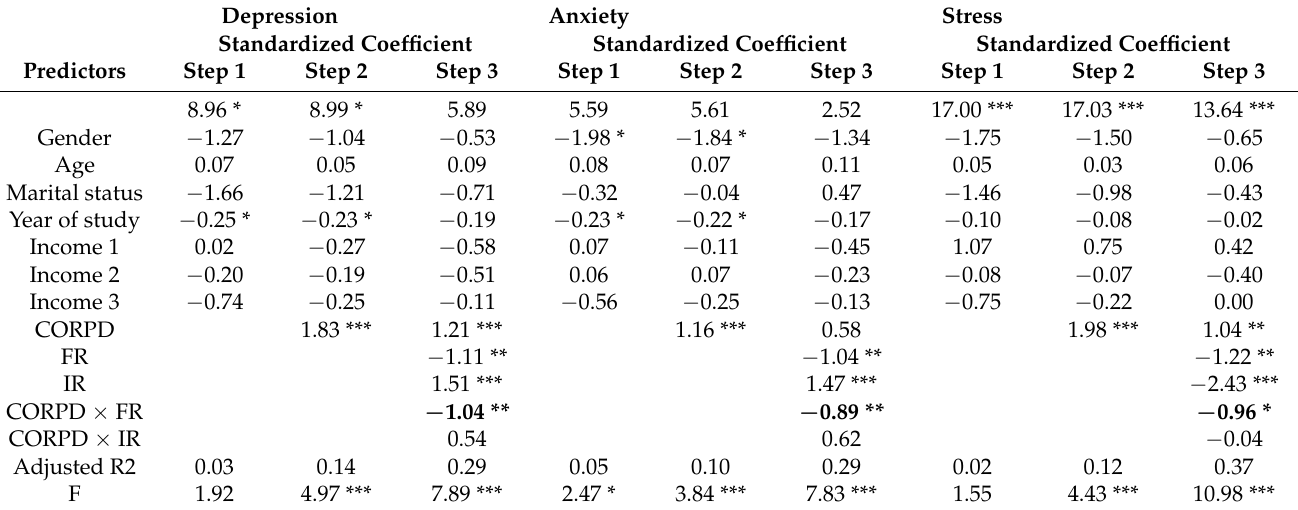
Table 3. Hierarchical regression analyses predicting mental health